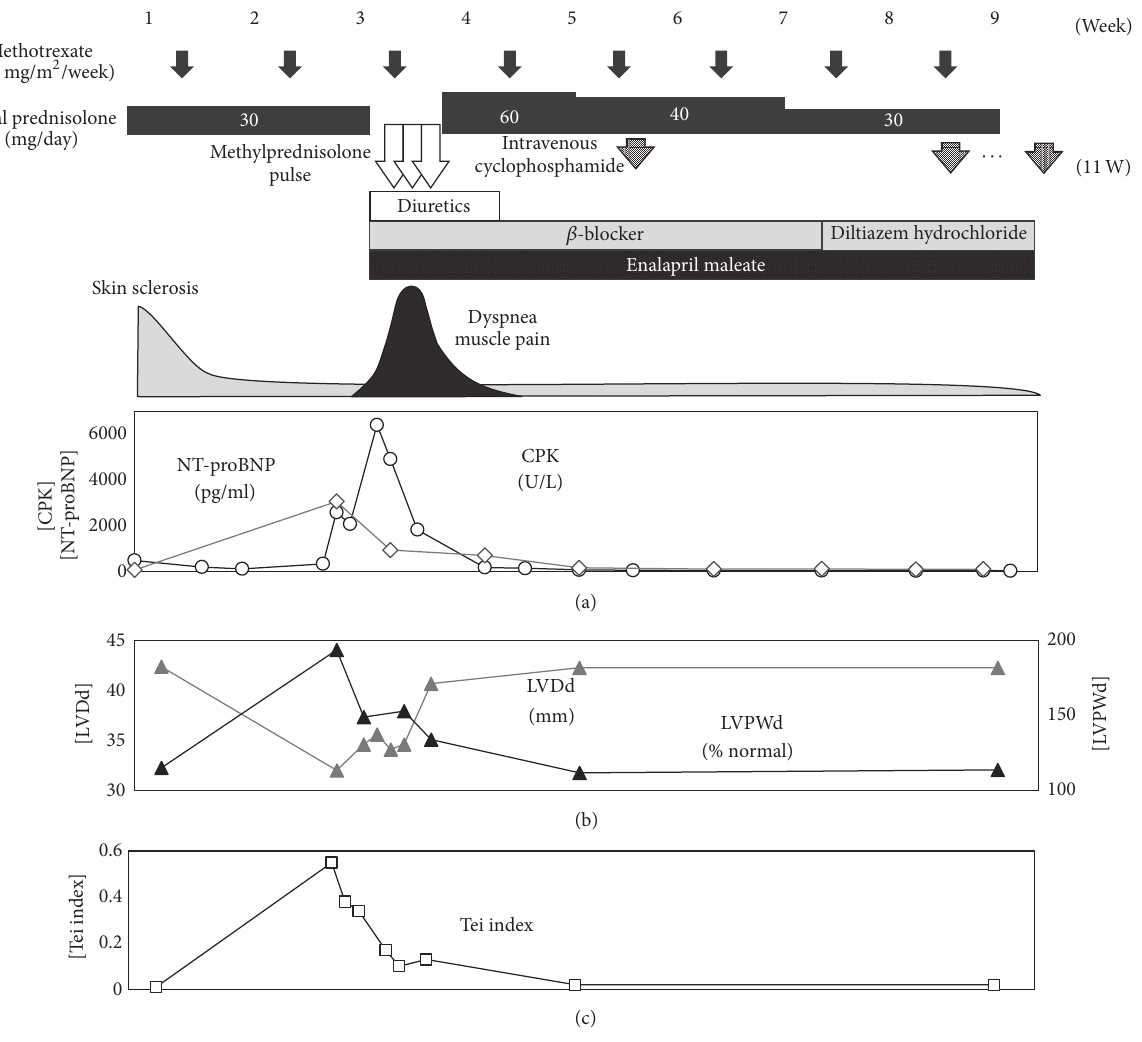
Figure 4: Nine-week time course after the initiation of treatment. Therapeutic agents, symptoms, creatine kinase (CK, shown as open black circles ingraph(a)),N-terminalprob-typenatriureticpeptide(NT-proBNP,shown asopen graycircles ingraph (a)),left ventricular posterior wall end diastole, percent of normal (LVPWD% N, shown as closed black triangles in graph (b)) and left ventricular diastolic diameter (LVDd, shown as closed gray triangles in graph (b)), and Tei index showing left ventricular diastolic and systolic function, calculated as [isovolumic contraction time + isovolumic relaxation time]/[left ventricular ejection time] (Tei index, shown as open squares in graph (c)) are shown. Cardiacdysfunctionandexacerbationofmyositisoccurredabruptlyandwereresolvedaftermethylprednisolonepulsetherapyincombination with palliative therapies for heart